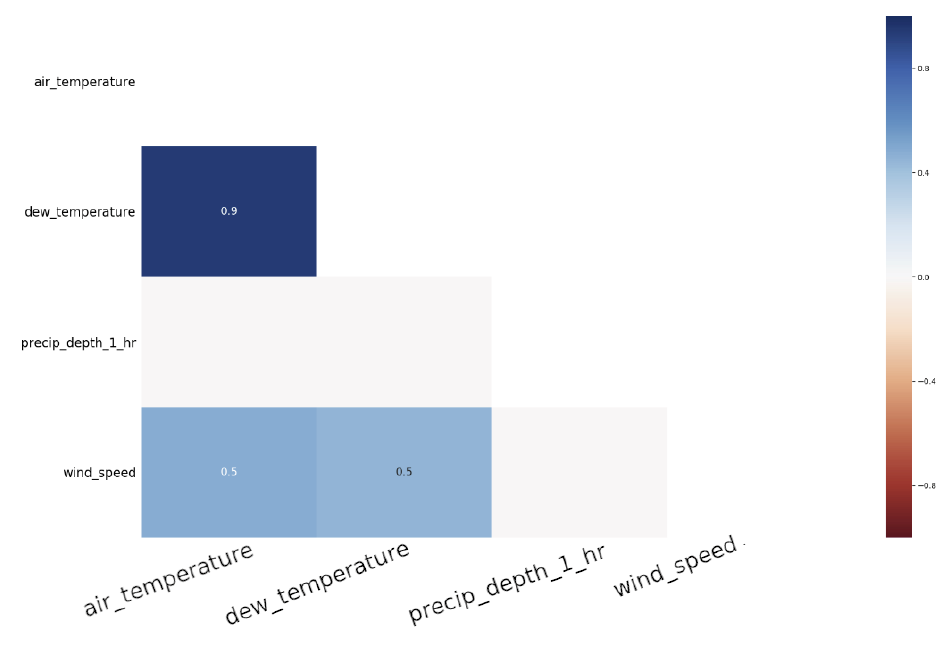
Figure 6. Correlation for selected variables.